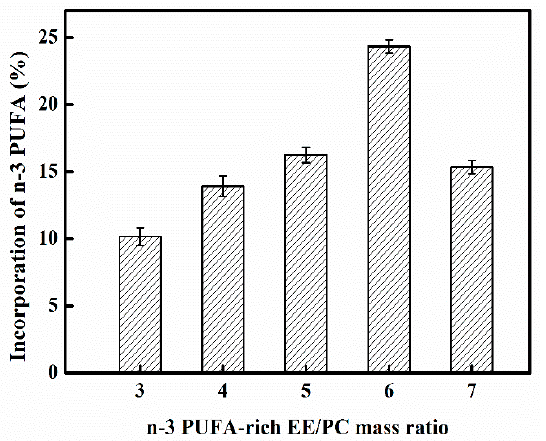
Figure 1. Effects of n-3 PUFA-rich EE/PC mass ratio on the incorporation of n-3 PUFA into PC. Reaction conditions were as follows: enzyme loading of 15% ( w / w ), water dosage of 1% ( w / w ), reaction temperature of 55 °C, reaction time of 24 h under N 2 .